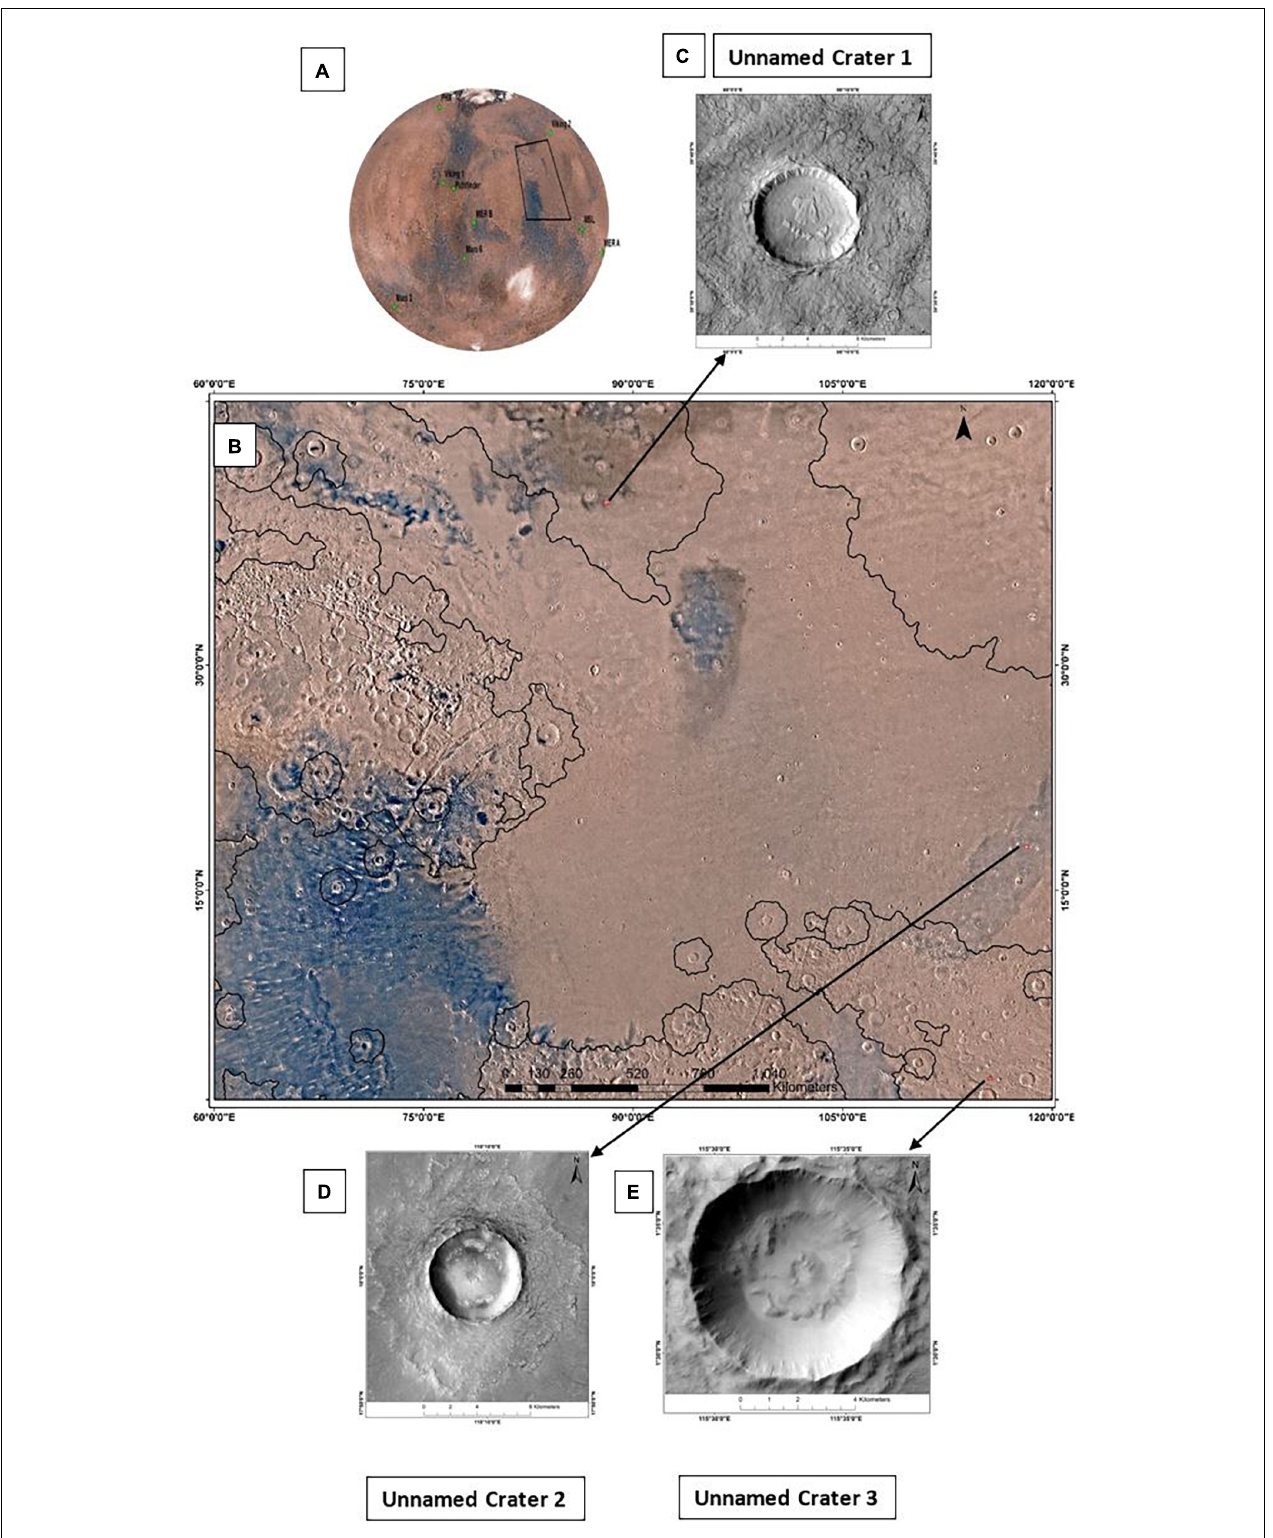
FIGURE 1 | (A) The study area on Mars in a global view used for chronological study, where the black box indicates the targeted studied region. (B) An enlarged view of the region of study in Viking data image with a pixel size of 232 m/pixel. For a detailed mineralogical and spectral study, craters were chosen (C) from the middle Amazonian lowland unit, (D) from the late Hesperian transition unit, and (E) from the late Noachian highland unit.